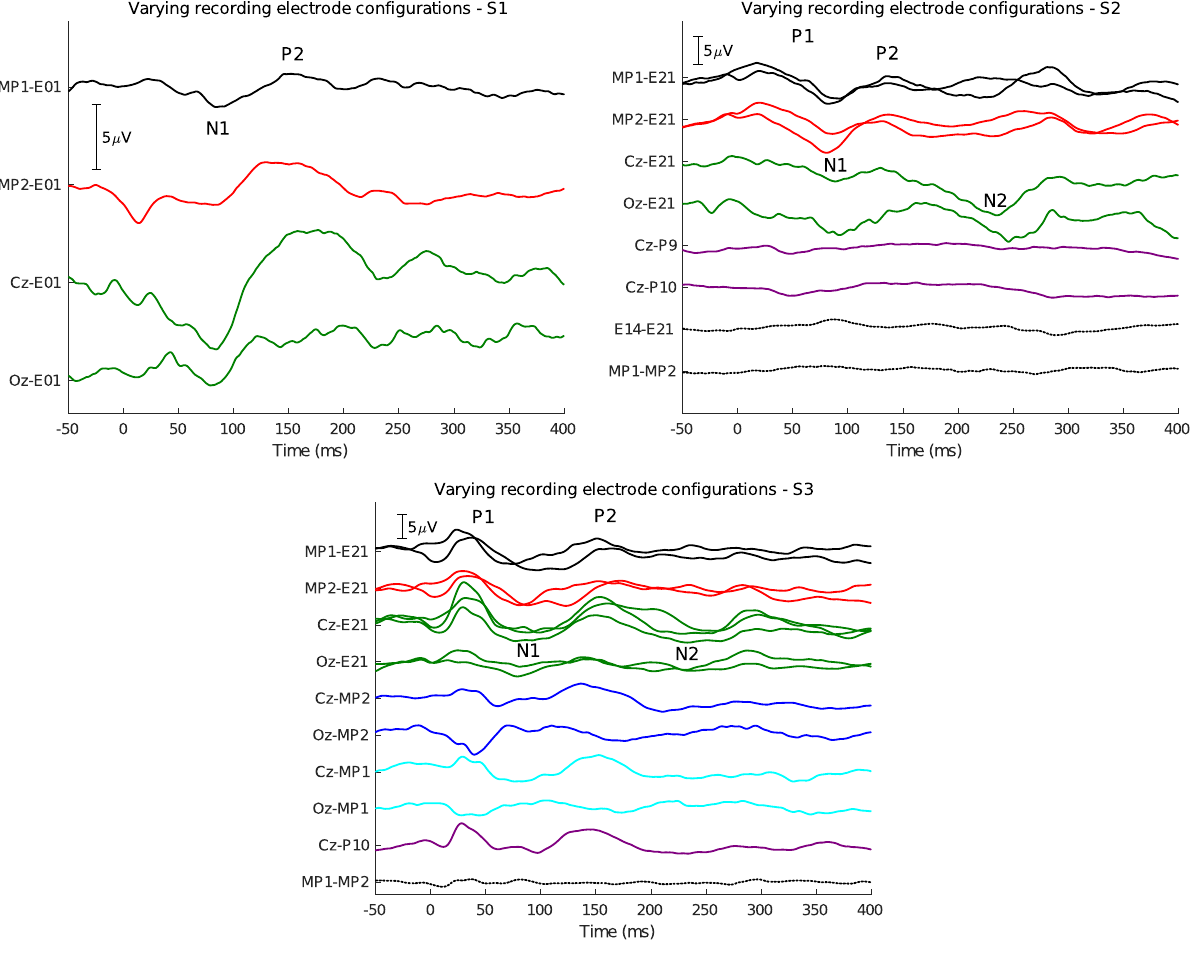
Figure 4. ECEPs recorded using various electrode configurations, indicated on the vertical axis and color- coded according to Fig. 1. P1, N1, P2 and N2 are marked on the traces where applicable. Repeated tests